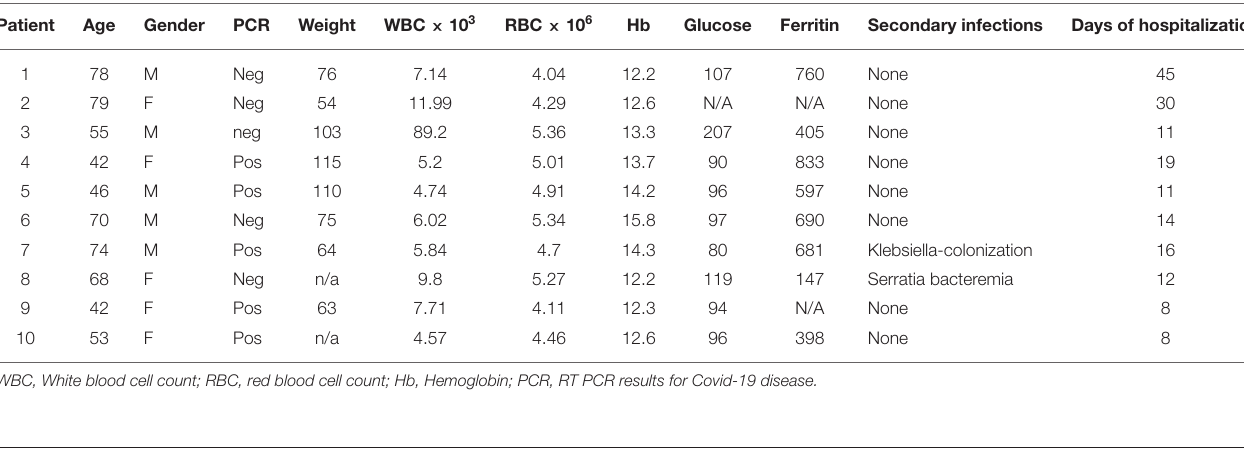
TABLE 1 | Clinical characteristics of the ten hospitalized Covid-19 patients.